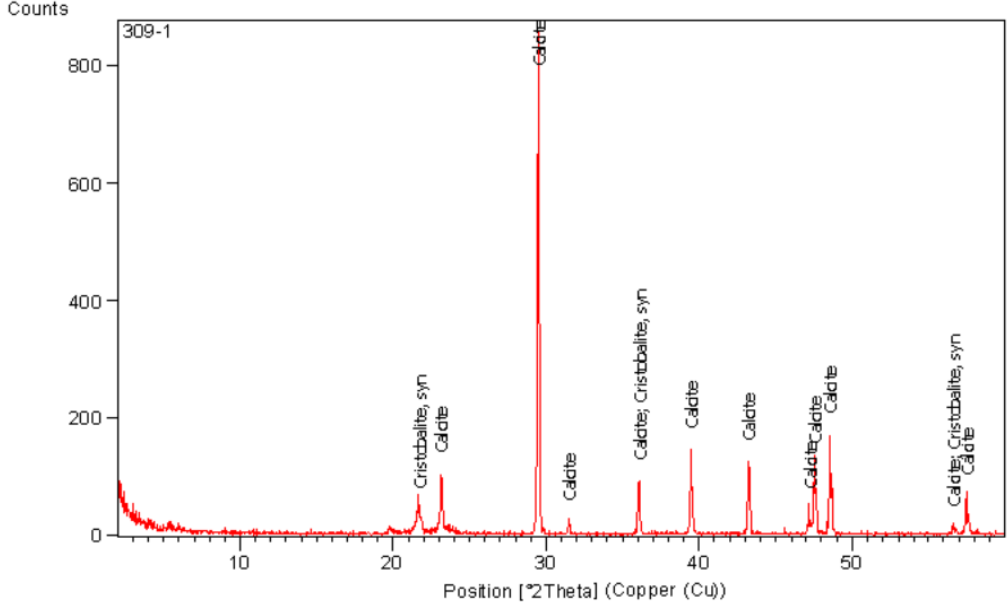
Figure 5. Mineralogical analysis of produced CaCO 3.